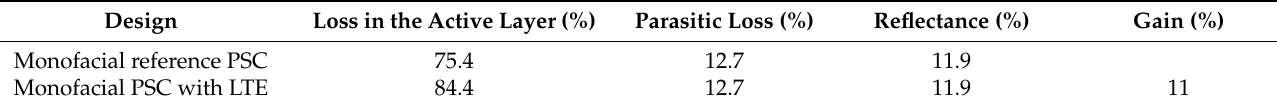
Table 1. Optical characteristics of monofacial perovskite solar cells.